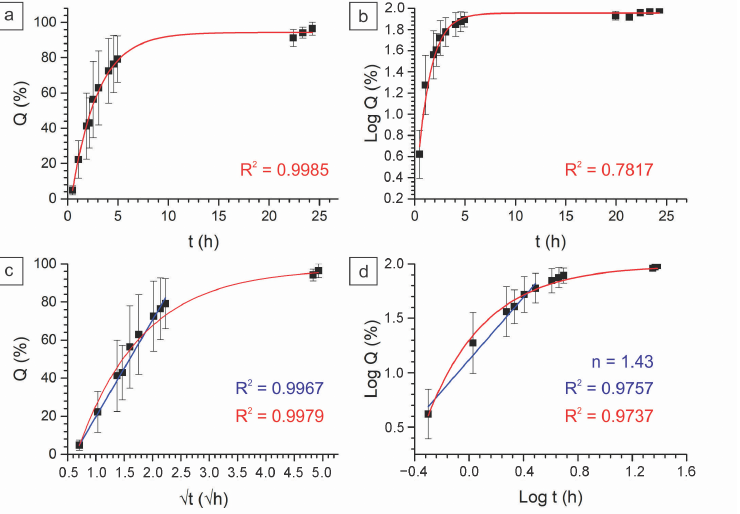
Figure 10. Release profiles of core–shell fiber PVA-PEG-1x-CHX@PVA-GO fitted to the models: ( a ) zero order, ( b ) first order, ( c ) Higuchi, and ( d ) Korsmeyer–Peppas